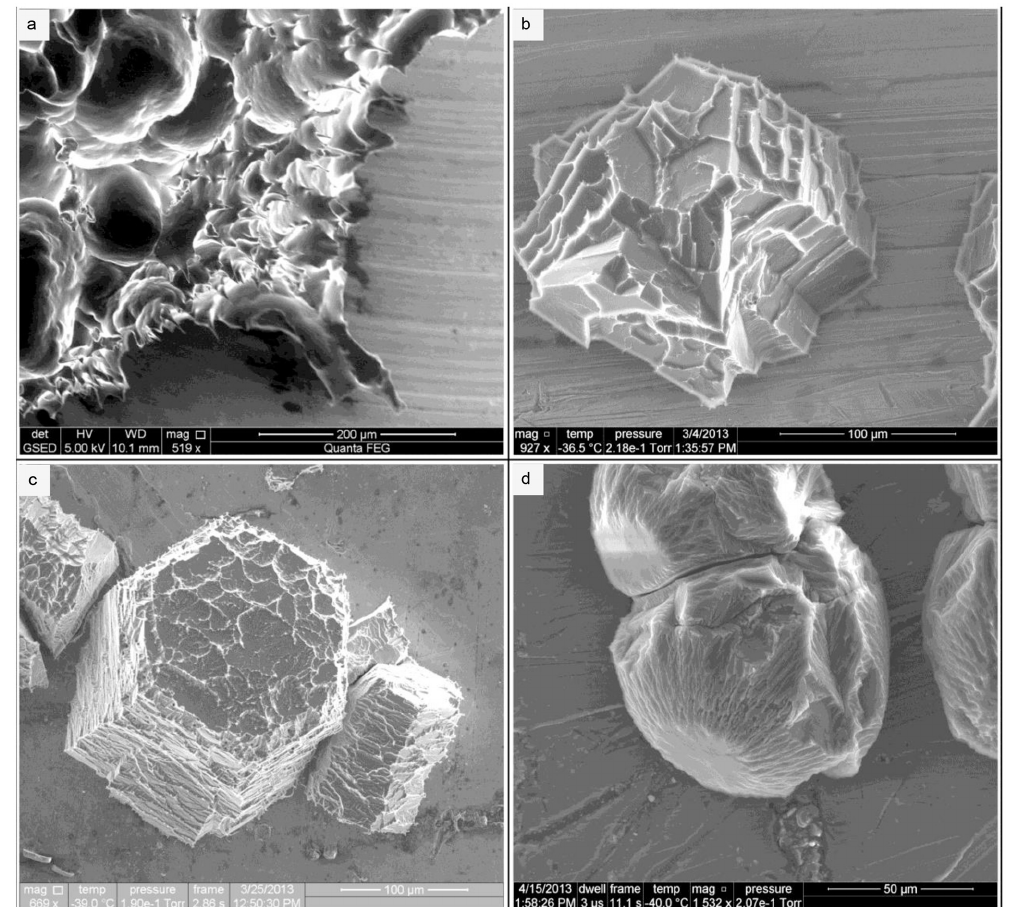
Figure 4. Sublimating ice crystals displaying scalloped depressions and sharp ridges and peaks of roughness. Panel (a) was originally composed of a polycrystalline ice particle, with peaks and ridges prominent at former grain boundaries. Data detail available in